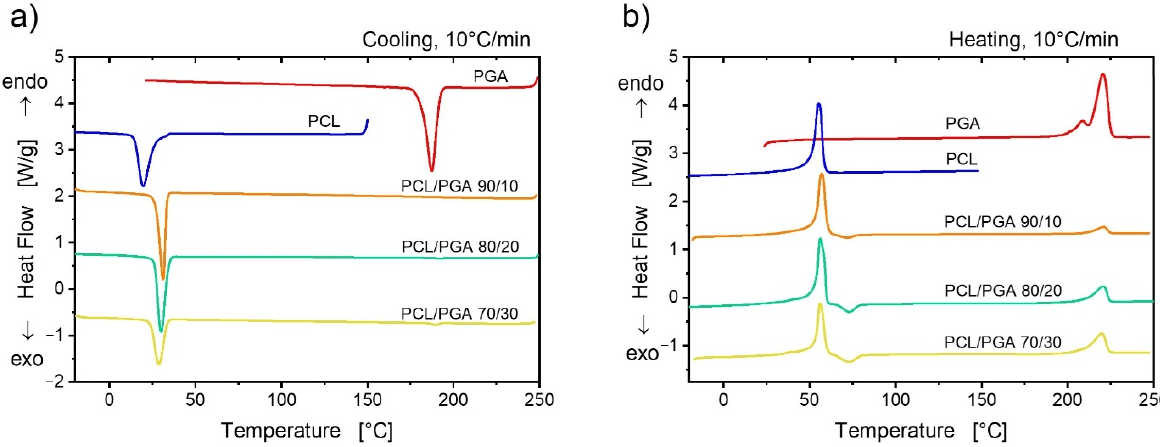
Figure 5. DSC cooling ( a ) and heating ( b ) scans for the neat polymers and PCL/PGA blends of indicated compositions.